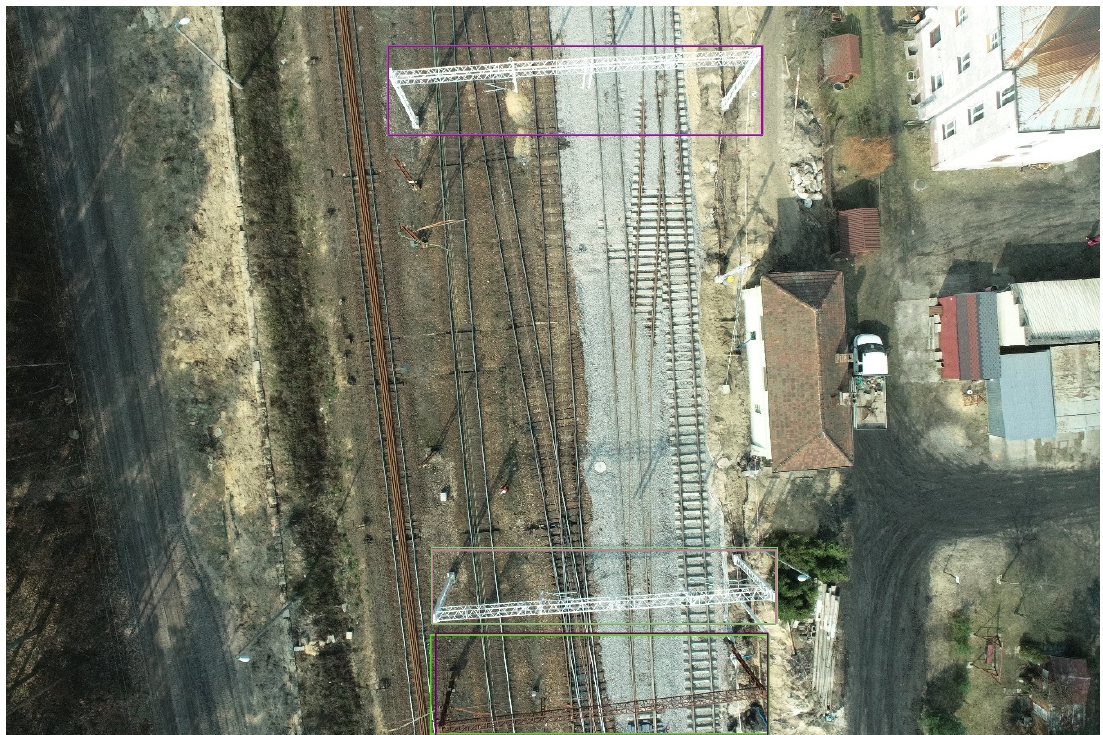
Figure 17. An example of comparing bounding boxes for gates obtained using automatic generation from ground-truth for the entire image. From the top, IoU values: 0.9935, 0.9698, 0.9629.